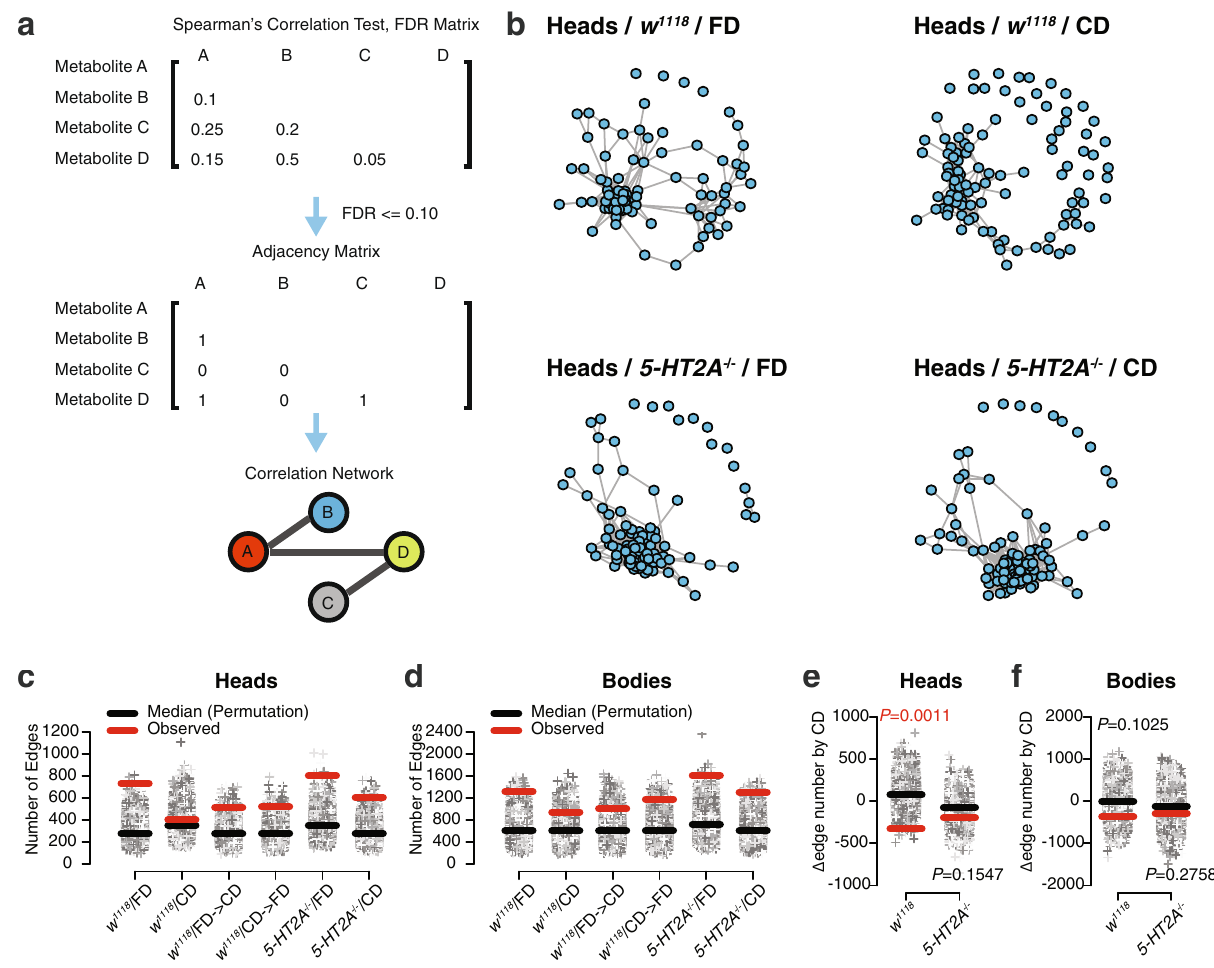
Fig. 2 Serotonin signaling modulates choice-induced edge number reduction. a Diagram illustrating correlation network construction. In brief, we estimated the signi fi cance of metabolites correlation using Spearman ’ s rank-order correlation coef fi cient test. Then, adjusted P values (by Benjamini – Hochberg procedure) were used for constructing adjacency matrices (with FDR = 0.1 as the cutoff). We used adjacency matrices to infer metabolite correlation networks, in which nodes represent individual metabolites and edges indicate links between them. b Visualization of the correlation networks using the Fruchterman – Reingold algorithm demonstrates similar organizations across different diets and genotypes. Each network consists of one large, highly connected core group together with many small satellite groups, which are disconnected from the core. Most of these satellites were comprised of a single, unconnected metabolite. c – f Permutation analysis is used to demonstrate whether the edge number differences between groups are signi fi cant. c , d Plots showing the edge number of real networks (denoted as the red bar) against randomized networks (gray dots represent edge number from 10,000 simulations, while black bars indicate the median of each group). In both heads ( c ) and bodies ( d ), the observed edge number is higher than the median of permutated ones from the same group, while the deviation is most extreme in fl ies that fed on a fi xed diet, suggesting diet-dependent effects on edge number. e , f Edge differences between dietary conditions are further calculated to evaluate statistical signi fi cance. Permutated data are used as